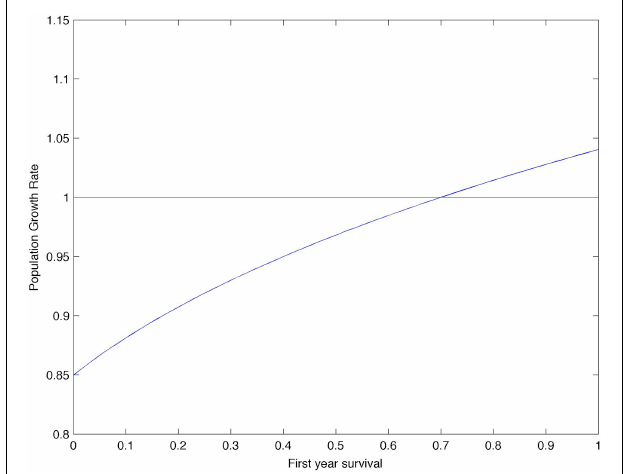
FIGURE 3 | Fitness landscape analysis. Population growth rate, λ , as a function of first-year survival, s0c.